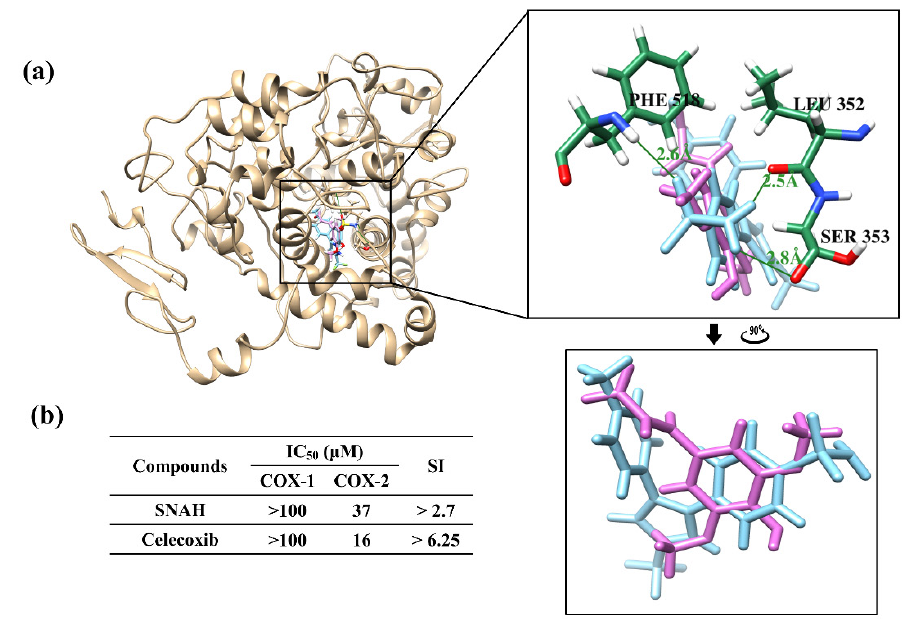
Figure 7. Docking simulation between SNAH and COX-2 (6COX). ( a ) The pink-colored chemical structure represents SNAH, and the COX-2 protein structure complexed with celecoxib is indicated by blue colored. The magnified rectangles indicate the active sites of COX-2 proteins. In the box image, hydrogen bond interactions between COX-2 and SNAH are depicted by green-colored lines. The binding energies of SNAH and celecoxib for COX-2 were − 6.4 kcal / mol and − 11.1 kcal / mol, respectively. ( b ) COX-2 enzyme inhibitory activities of SNAH. The commercial standard, celecoxib was used as a positive control at identical concentrations.